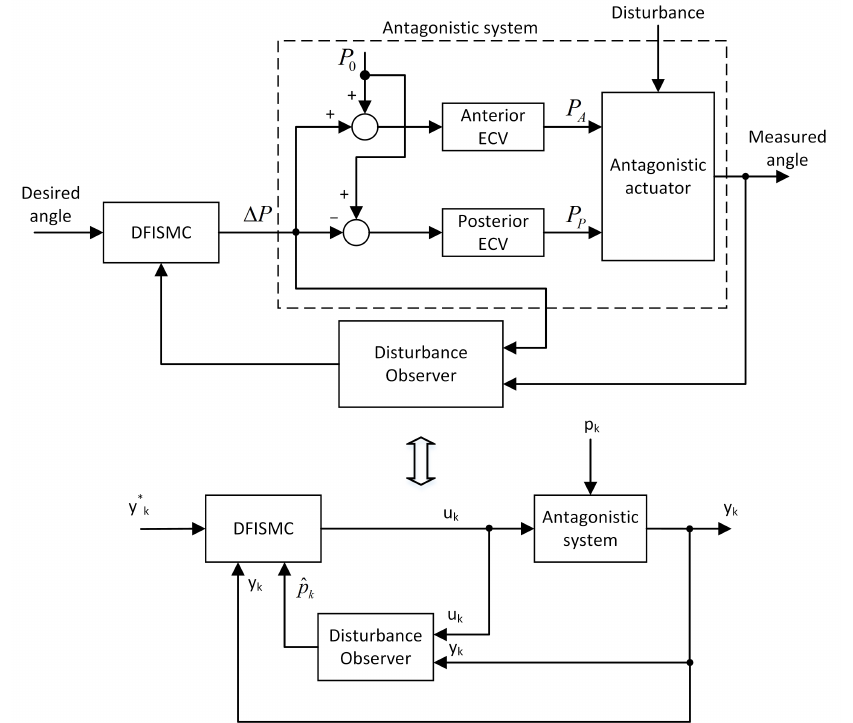
Figure 3. Block diagram of the discrete-time fractional integral sliding mode